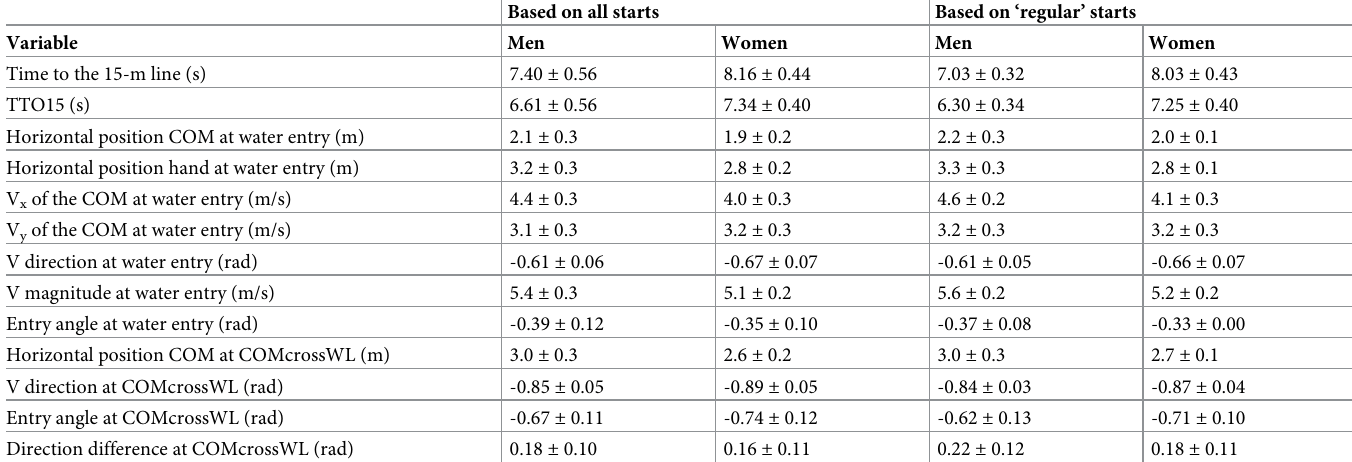
Table 4. Overview of the values (mean ± standard deviation) for the variables of all starts (left) and for the variables of the ‘regular’ starts (right) for men (N = 8) and women (N = 6). Based on all starts